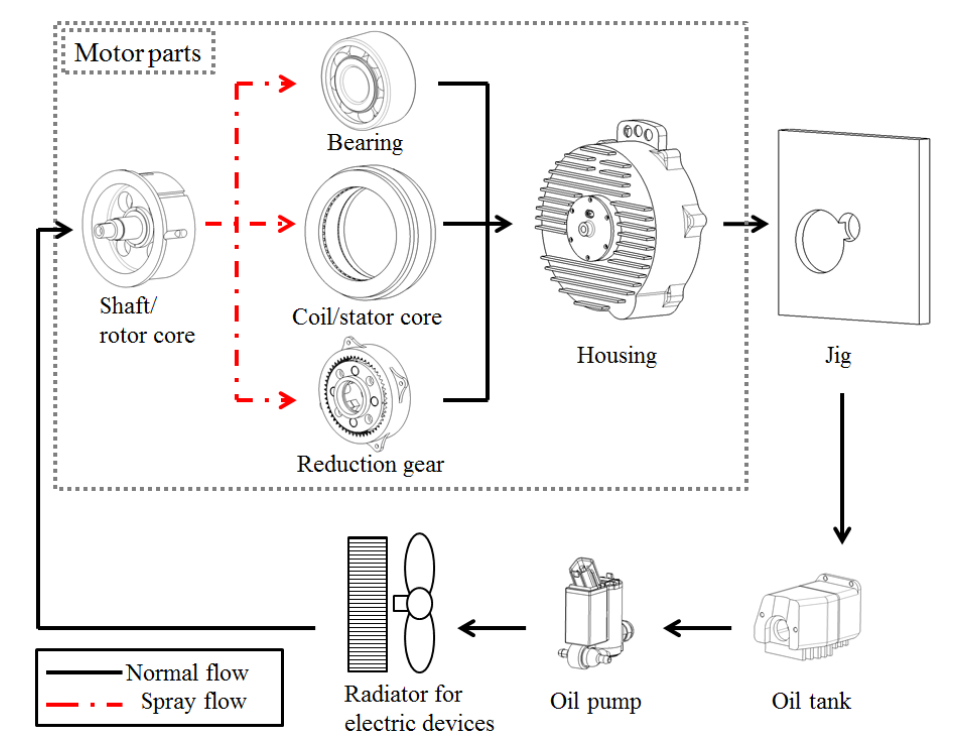
Figure 2. Flow circuit of the cooling